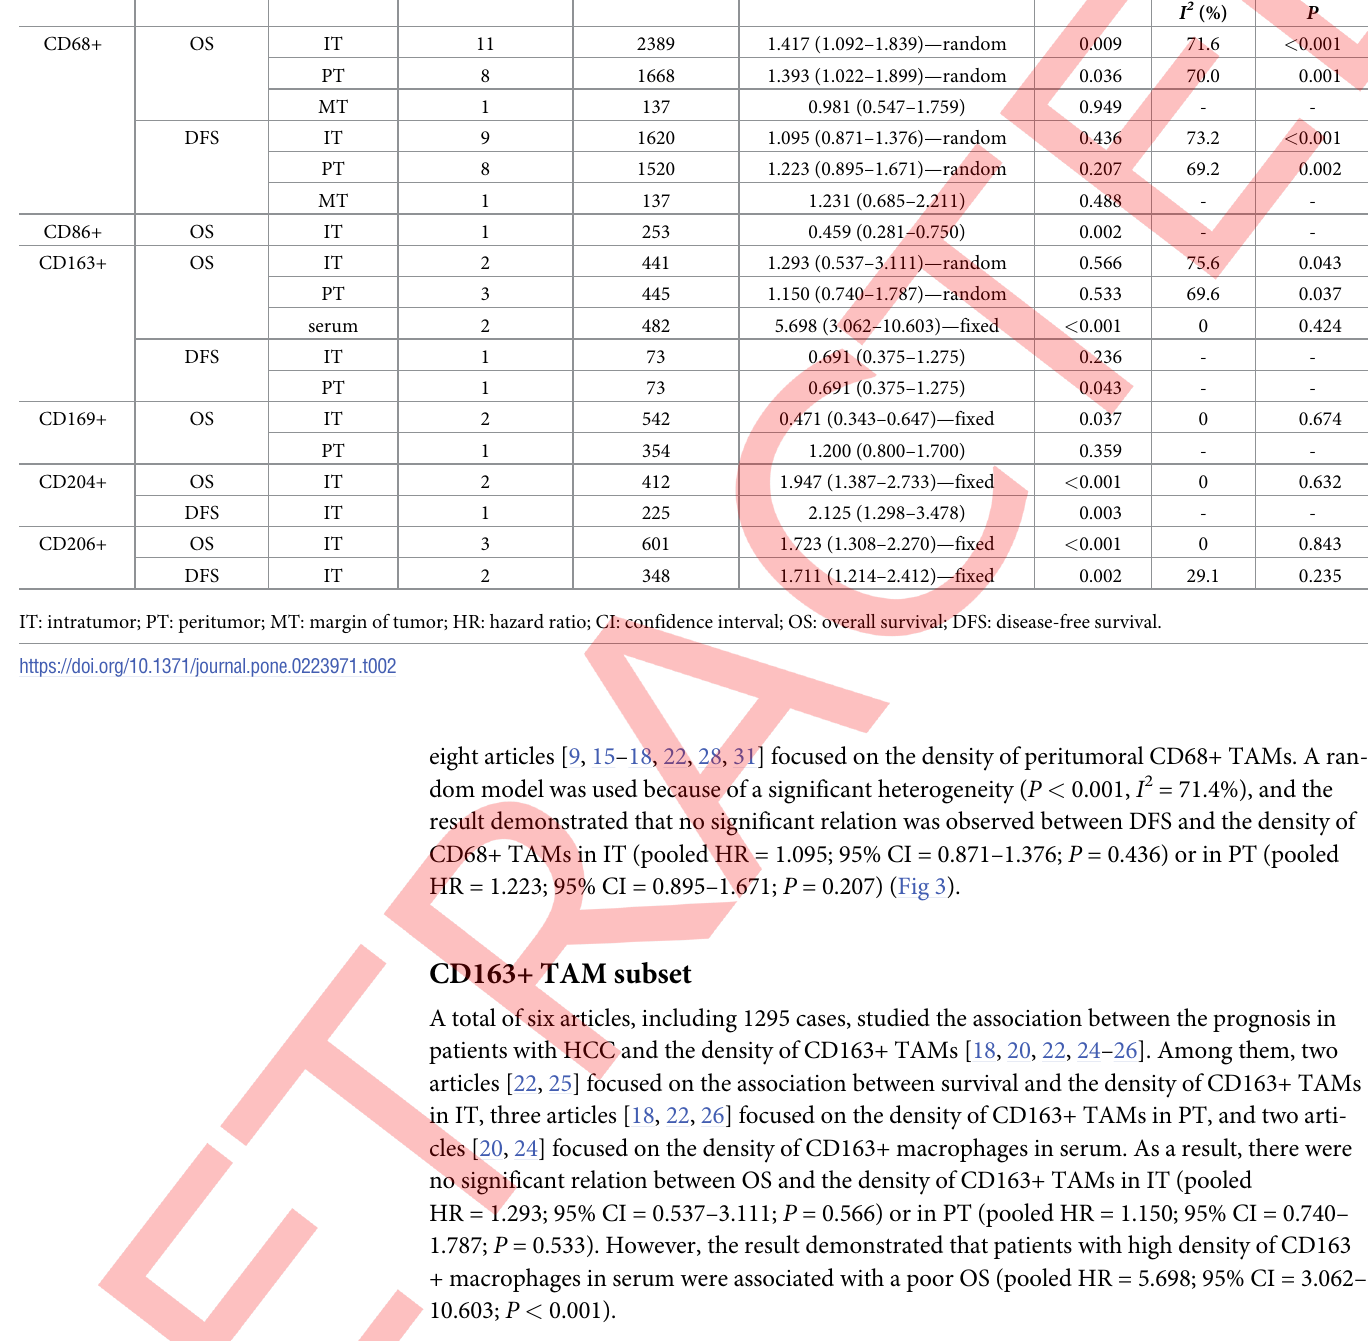
Table 2. The pooled associations between TAMs subsets and the prognosis of patients with HCC.